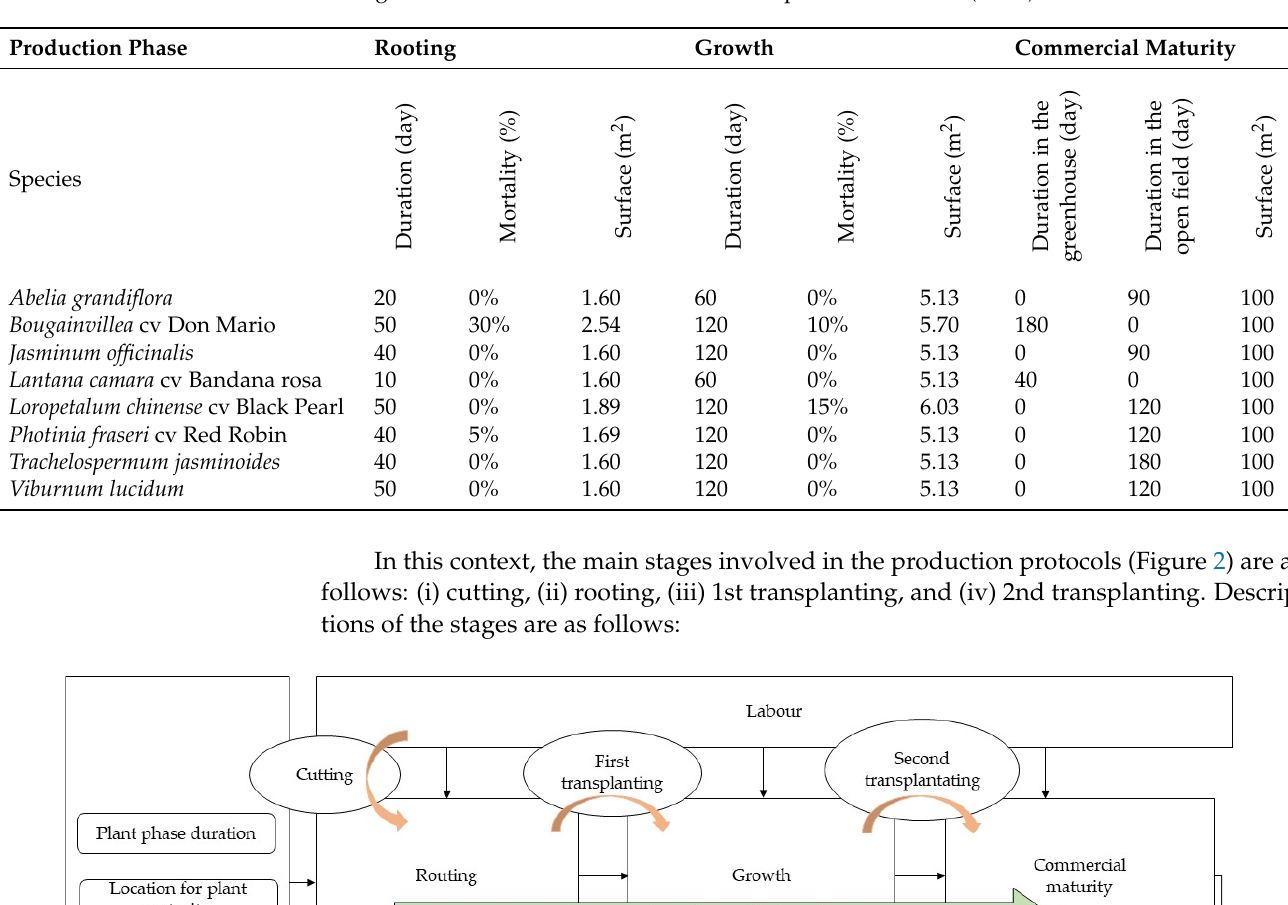
Table 2. Technical parameters used to calibrate the number of inputs to produce 1000 potted plants through the novel and sustainable ornamental production model (NSM).